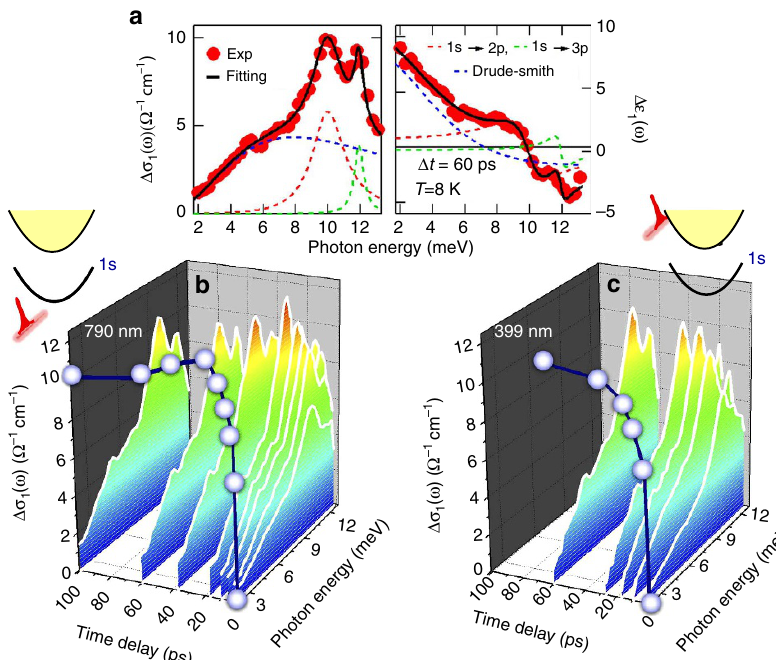
Figure 3 | Ultrafast THz Snapshots of formation pathways of excitonic Rydberg states. ( a ) The THz response functions (red dots) measured under 790nm wavelength and 550 m Jcm (cid:2) 2 fluence, at T ¼ 8K and pump probe delay D t ¼ 60ps. The fit (black lines), based on the analytical model of equation (1), is the sum of 1 s - 2 p (dashed red lines), 1 s - 3 p (dashed green lines) and unbound e-h carriers (dashed blue lines). ( b , c ) Photoinduced conductivity changes D s 1 ( o ) at several pump-probe delays and T ¼ 8K after excitation at 790nm (550 m Jcm (cid:2) 2 fluence) and 399nm (120 m Jcm (cid:2) 2 fluence), respectively. The shaded circles are the effective transition strength A X , extracted from photoinduced internal quantum transitions of excitons. 1 s ! 2 p for both excitations which allows to underpin their distinctly different rise times. The pump fluences are chosen to induce approximately equivalent A X 1 s ! 2 p